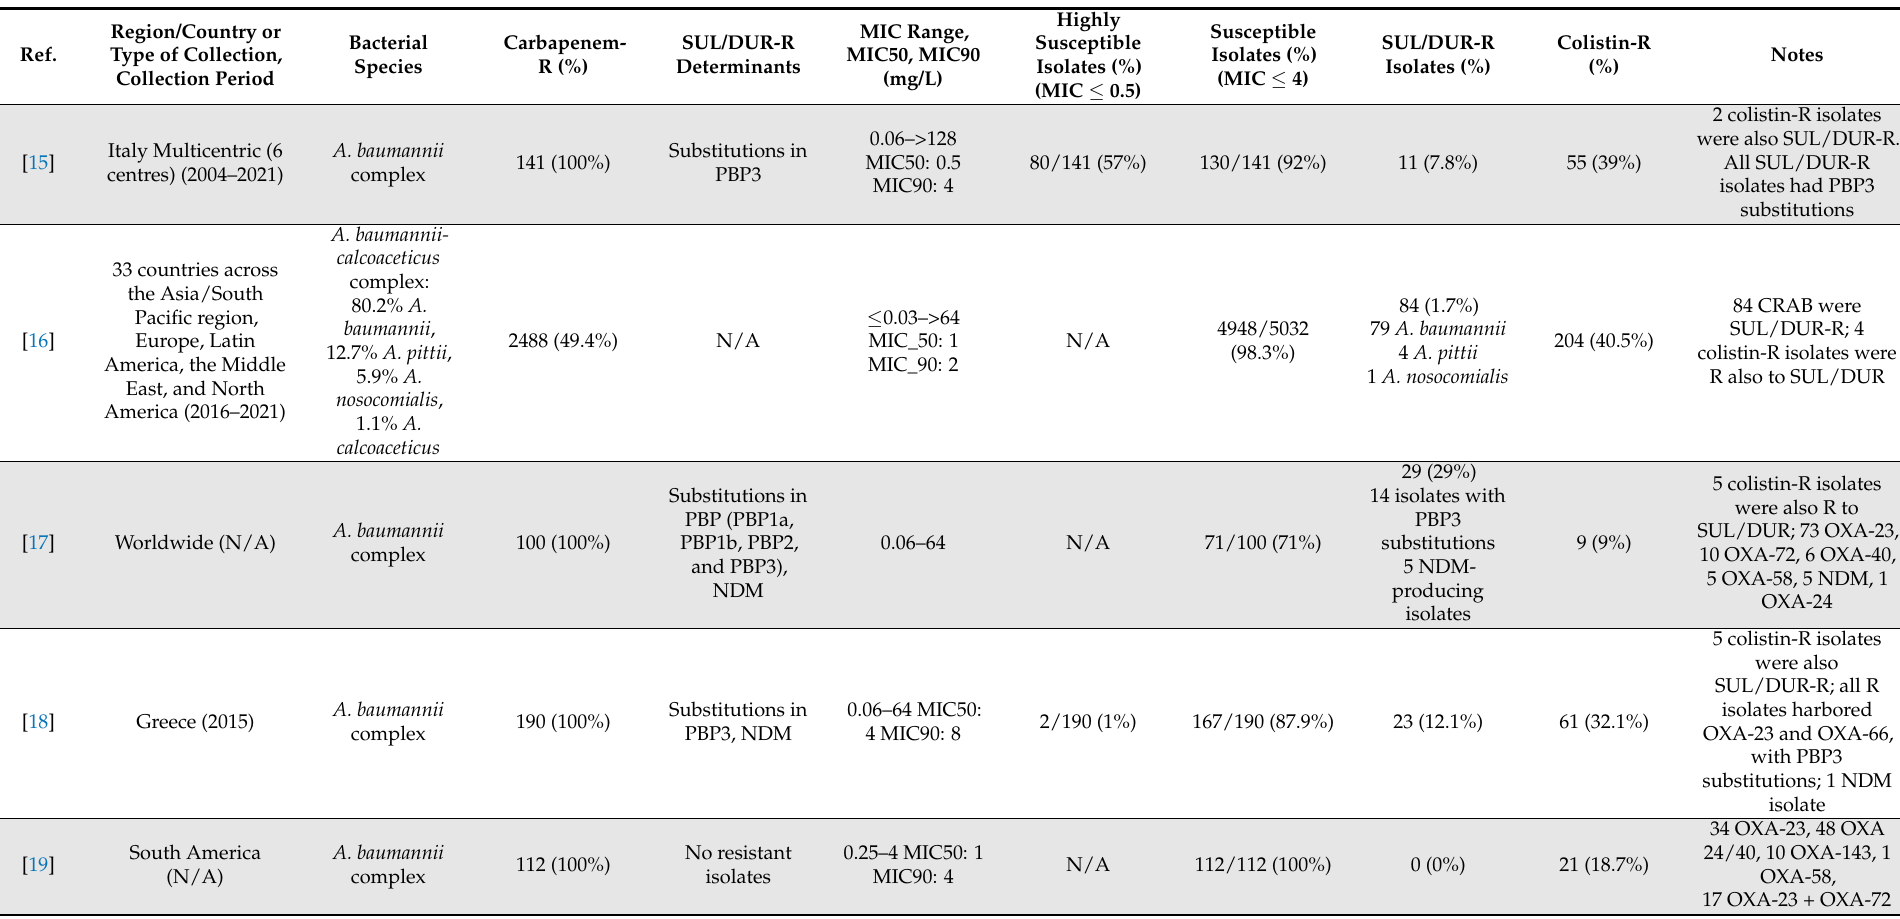
Table 1. In vitro studies on sulbactam/durlobactam antimicrobial activity against Acinetobacter isolates.